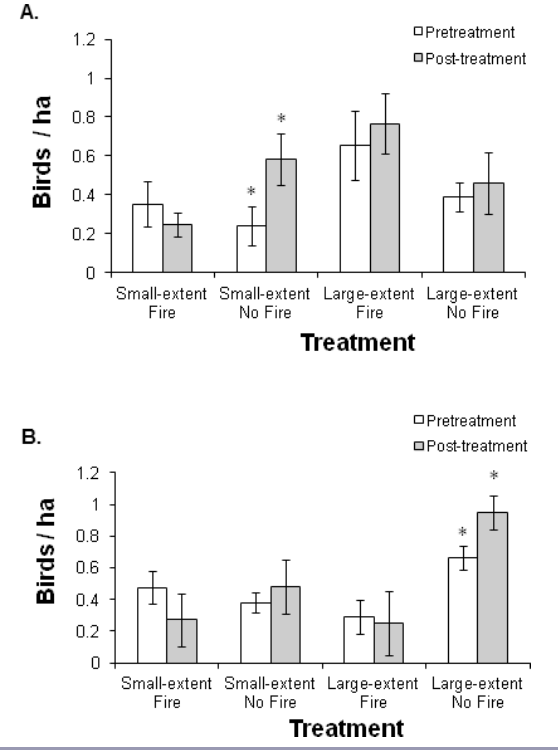
Fig. 2 . Changes in density of male Bachman’s Sparrows ( Peucaea aestivalis ) in 2006 (A) and 2007 (B) in response to large- or small-extent plots, pre- and postburn time periods, and burned and unburned fire treatments. Density estimates were pooled for months preceding application of prescribed fire and those following application. Error bars are 95% confidence intervals (*, significance at the 0.05 level).